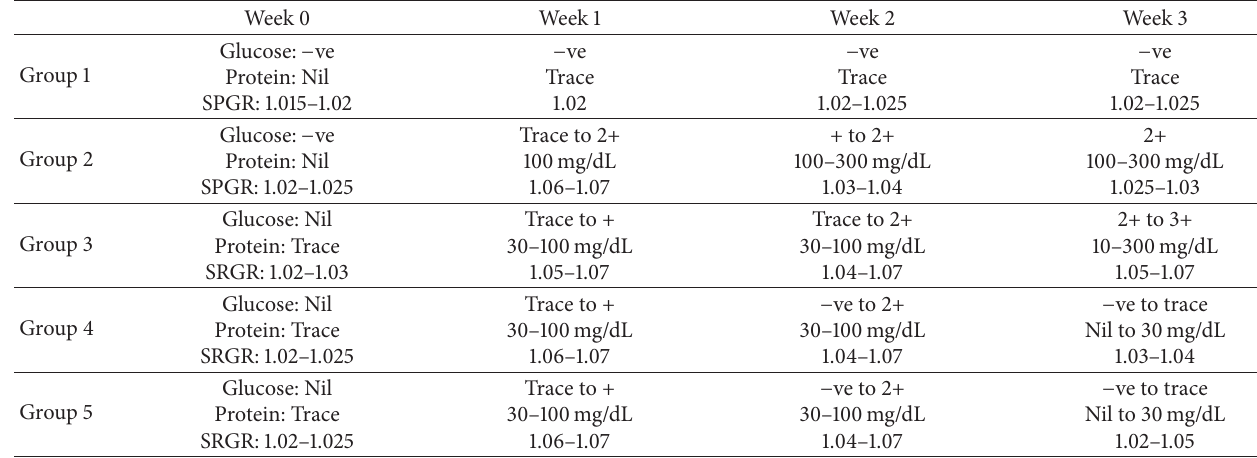
Table 2: Biochemical parameters in the urine of diabetic and non-diabetic rats.